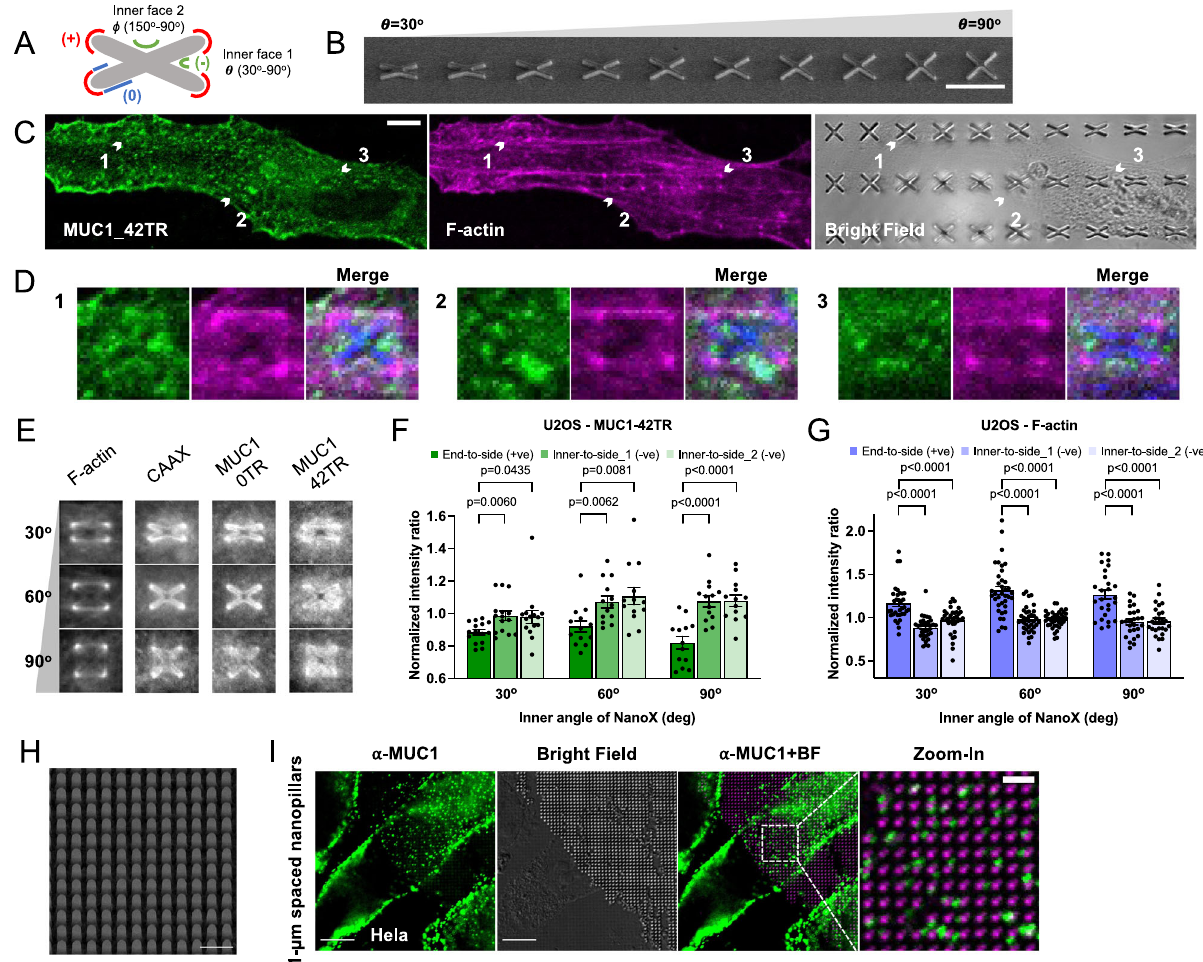
Fig. 2 MUC1 prefers negatively-curved over positively-curved membranes on the same nanostructures. A Schematic illustration of a nanoX used to induce positive, negative, and zero membrane curvature on the same structure. B An SEM image of gradient nanoX arrays with inner angles ranging from 30° (left) to 90° (right), tilted at 45°. All nanoX are 350 nm in arm width, 5 µ m in arm length, and 10 µ m in spacing. NanoX inner angle ( θ ) increment: 15°. C Confocal images of MUC1_42TR-GFP-transfected U2OS cells cultured on the gradient nanoX arrays. F-actin was stained with phalloidin as a reference. D Three sets of zoom-in confocal images show that F-actin prefers the arm ends of nanoXs while MUC1_42TR-GFP prefers the inner faces. Bright- fi eld images of nanoX structures were converted into blue color for visualization purpose. E Averaged fl uorescence images show the spatial distributions of, F- actin, mCherry-CAAX, MUC1_0TR-GFP, and MUC1_42TR-GFP on nanoXs. F , G Quanti fi cation of end-to-side ratios (re fl ecting the preference for positive curvature) and inner-to-side ratios (re fl ecting the preference for negative curvature) of MUC1_42TR-GFP ( F ) and F-actin ( G ) on nanoXs of selected three inner angles. All ratios are normalized against the mCherry-CAAX signals (see Supplementary Table 3A, C for the detailed statistics). H An SEM image of a dense nanopillar array at 500-nm-diameter, 1- μ m-height, and 1- μ m-spacing with a stage tilt of 45°. I Confocal images of Hela cells cultured on the dense nanopillar array. MUC1 preferentially locates to inter-pillar spaces where negative membrane curvature can be induced. The bright- fi eld (BF) channel in the merged image is background-subtracted and converted into magenta color for visualization. Scale bars = 10 µ m for B , C , I . Scale bars = 2 µ m for H and zoom-in images in I . Welch ’ s t -tests (unpaired, two-tailed, not assuming equal variance) are applied for all statistical analyses in this fi gure. Error bars represent as the one shown in Fig. 2H) 37 . For dense nanopillar arrays, the to biologically-induced membrane curvature, we employed inter-pillar spacing can accommodate or induce the formation of membrane-sculpting proteins, IRSp53, an inverse BAR (I-BAR) membrane protrusions with negative curvature. The localization protein to induce membrane protrusions with negative curvature of MUC1 at inter-pillar spaces further supports the observation (Fig. 3A) 42,43 , and FBP17, an F-BAR protein to generate mem- brane invaginations with positive curvature (Fig. 3B) 43,44 . A that MUC1 avoids positive membrane curvature induced by truncated FBP17- 4 SH3 mutant (simply denoted as FBP17) was nanostructures while preferring negative membrane curvature. A used since it induces membrane invaginations without activating puncta-like distribution of immunostained MUC1 in HeLa cells downstream signaling events 45 . U2OS cells usually have few (Fig. 1K, L and Supplementary Fig. 9C) might also re fl ect its protruding or invaginating structures, as seen in mCherry- preference for membrane protrusions with negative curvature. CAAX-expressing cells with co-expressing MUC1 variants (Supplementary Fig. 10). MUC1 avoids positively-curved membranes induced by Cells expressing IRSp53-mCherry show dramatic growth of membrane-sculpting proteins . To examine how MUC1 responds protrusions at the cell periphery, while cells expressing mCherry-